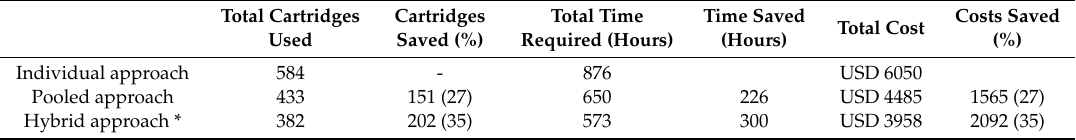
Table 4. Cost and time estimates utilizing di ff erent testing